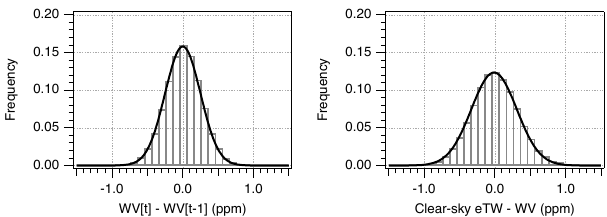
Figure 11. Left: histogram of 1s changes in the WV channel (strong line) during the 21–22 February 2013 flight. The width of the Gaus- sian fit to the distribution is 0.34, indicating the signal noise is nor- mally distributed with σ = 0.17ppm. Right: histogram of the differ- ence between 1s measurements in the TW and WV channels dur- ing cloud-free sampling periods of the 21–22 February 2013 flight. The difference is normally distributed around 0 with a width of 0.45ppm. This scatter yields a detection threshold (2 σ) for iner- tially enhanced ice water content, eIWC, of